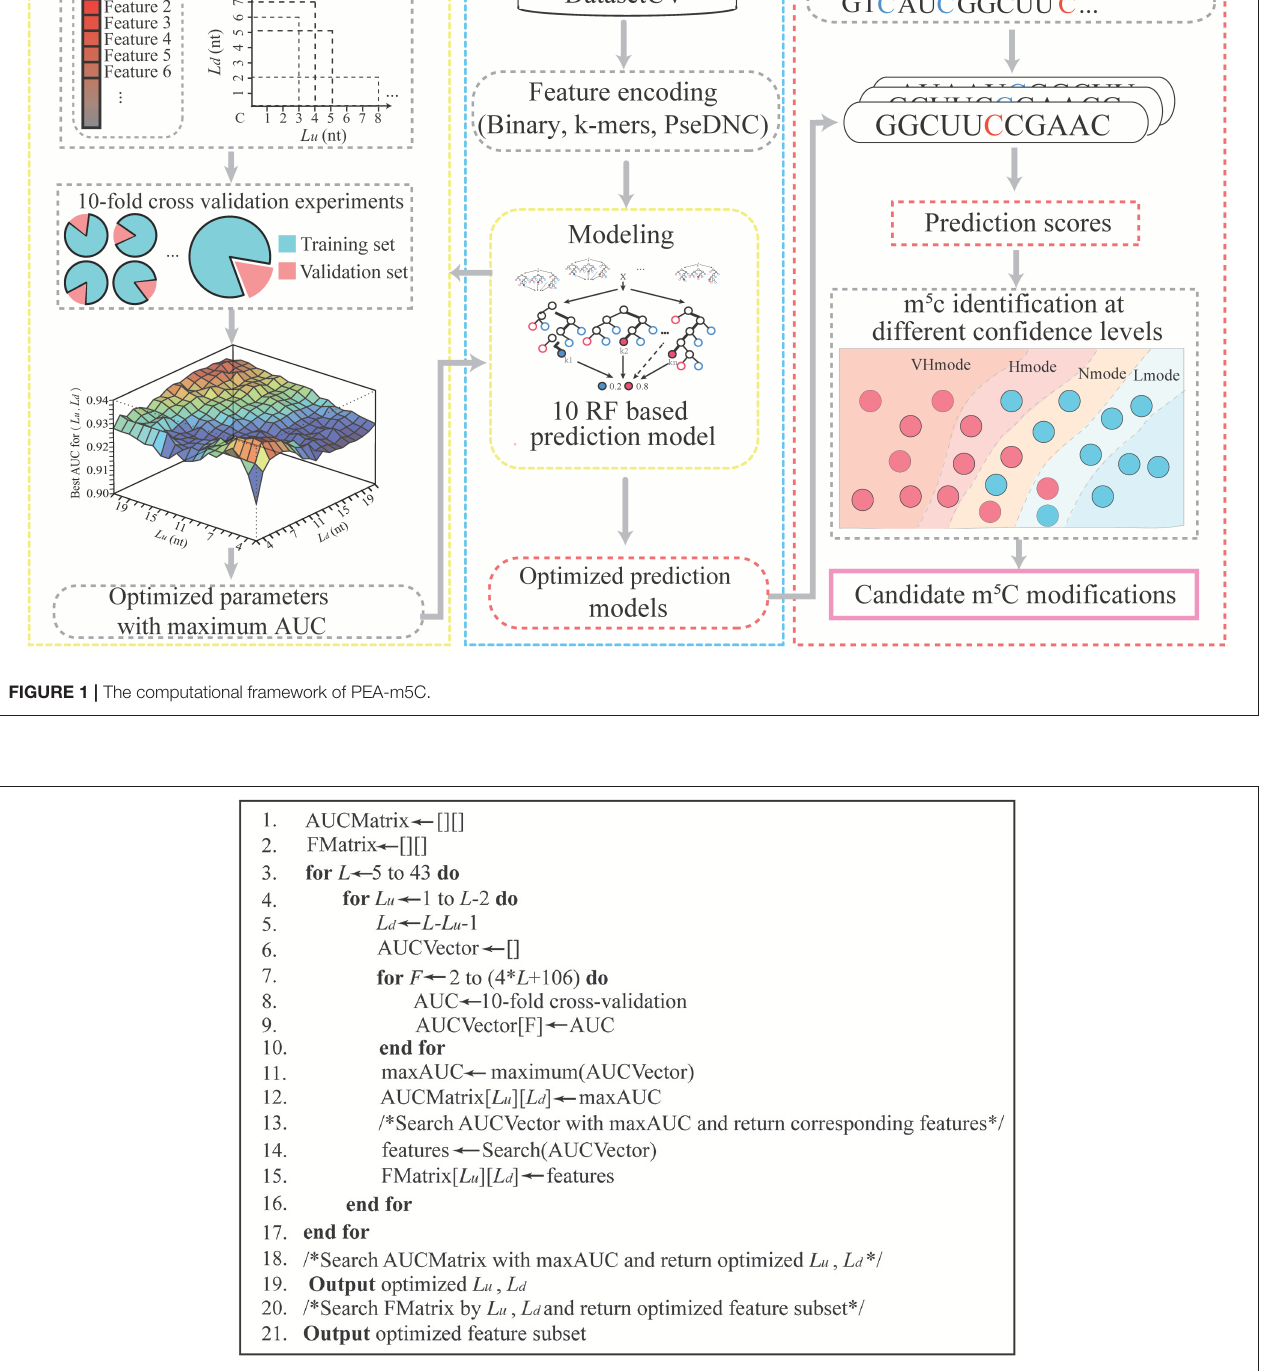
FIGURE 2 | The pseudo-code for model